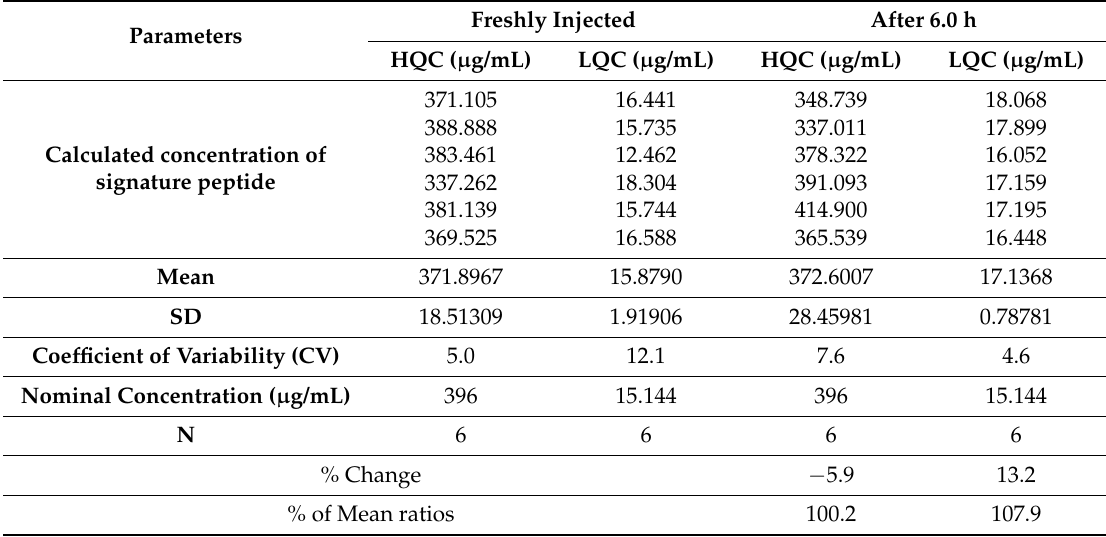
Table 4. Stability data of trastuzumab signature peptide (IYPTNGYTR) after 6 h incubation at 4 ◦ C in human serum batch. Mean ratio; 100.2% and 107.9% and % change; − 5.9 and 13.9 was observed at HQC and LQC level, respectively. Here, n represents the number of samples analyzed for the stability